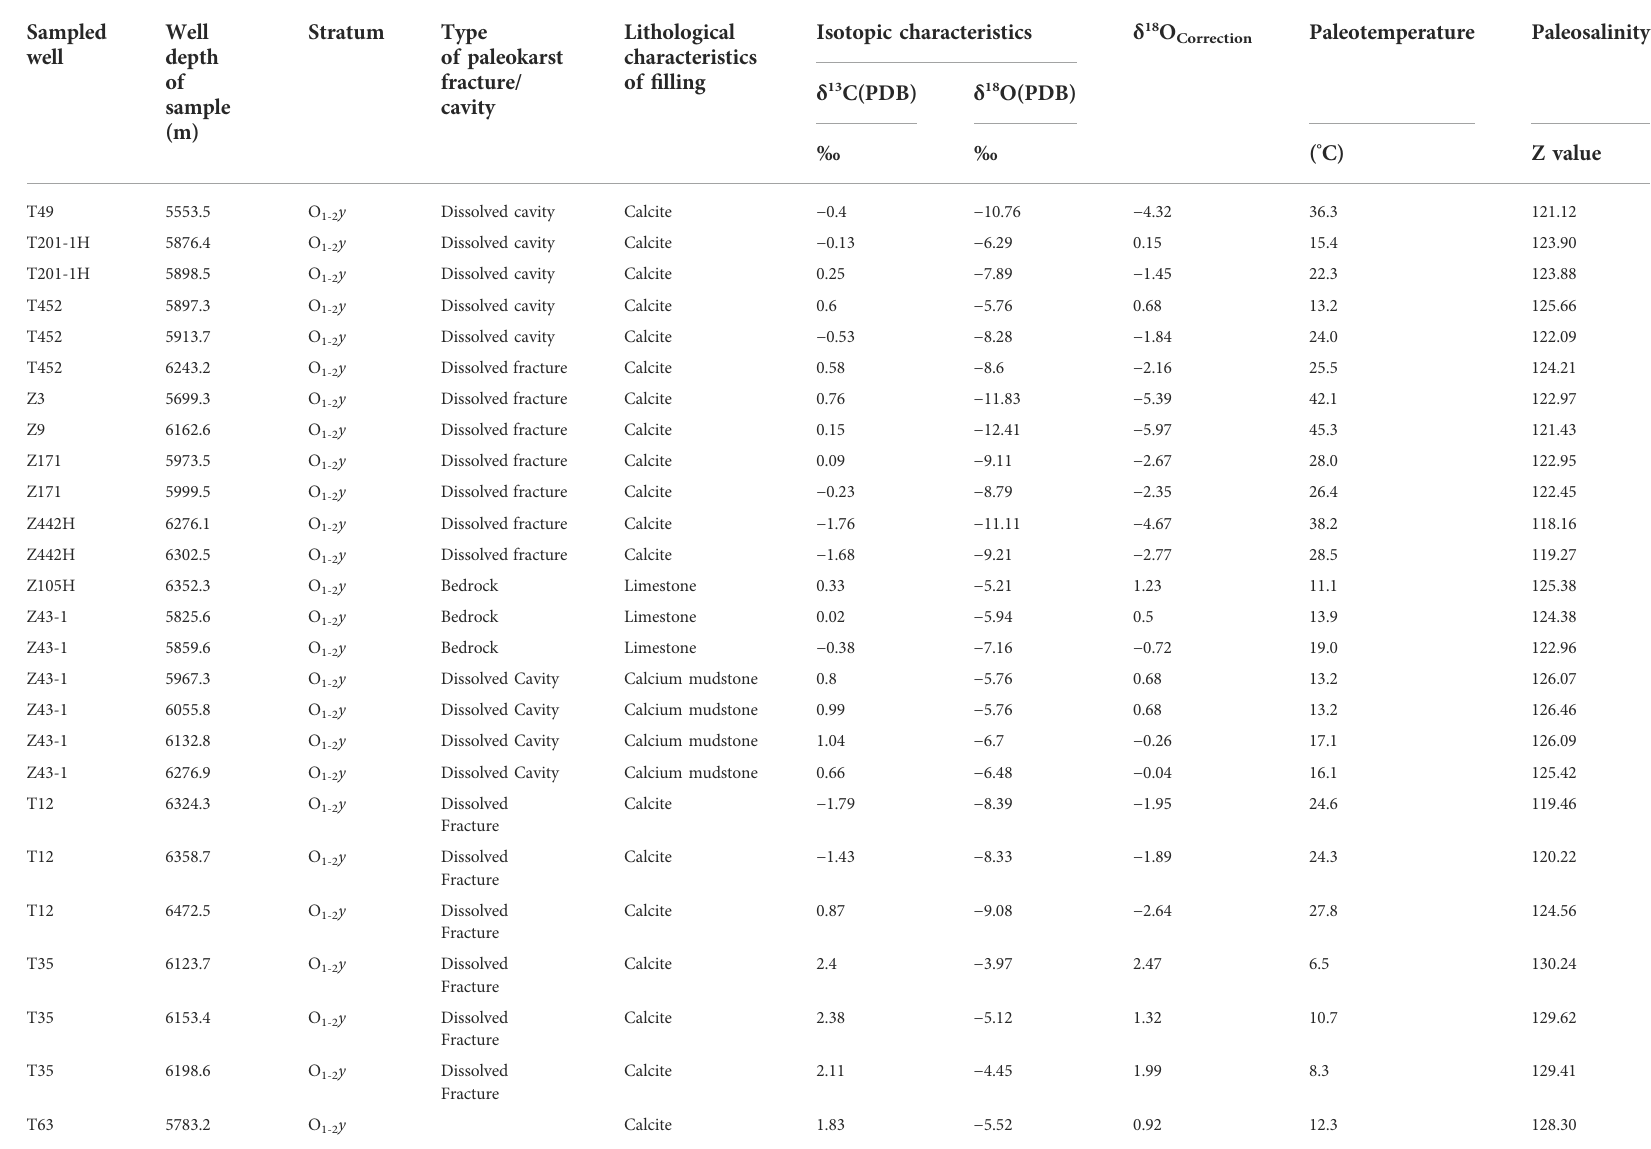
TABLE 1 Carbon and oxygen isotopic characteristics of Ordovician carbonate karst fi ssure fi llings from the Tazhong region. Sampled